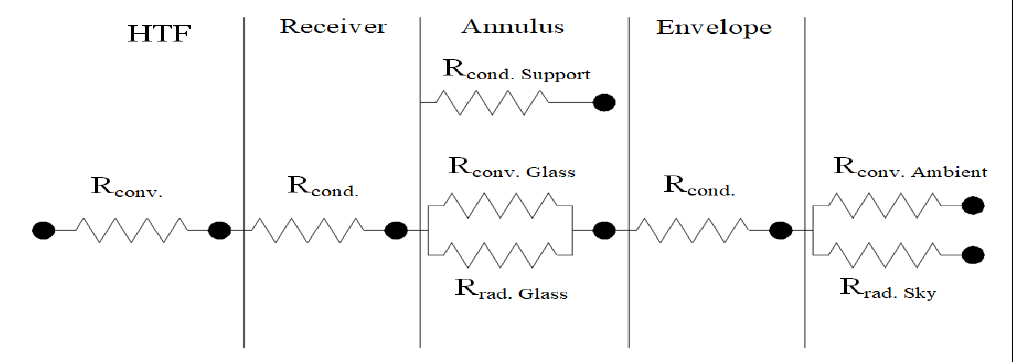
Figure 2. The parabolic trough collector (PTC) thermal resistance model. HTF, heat transfer fluid.